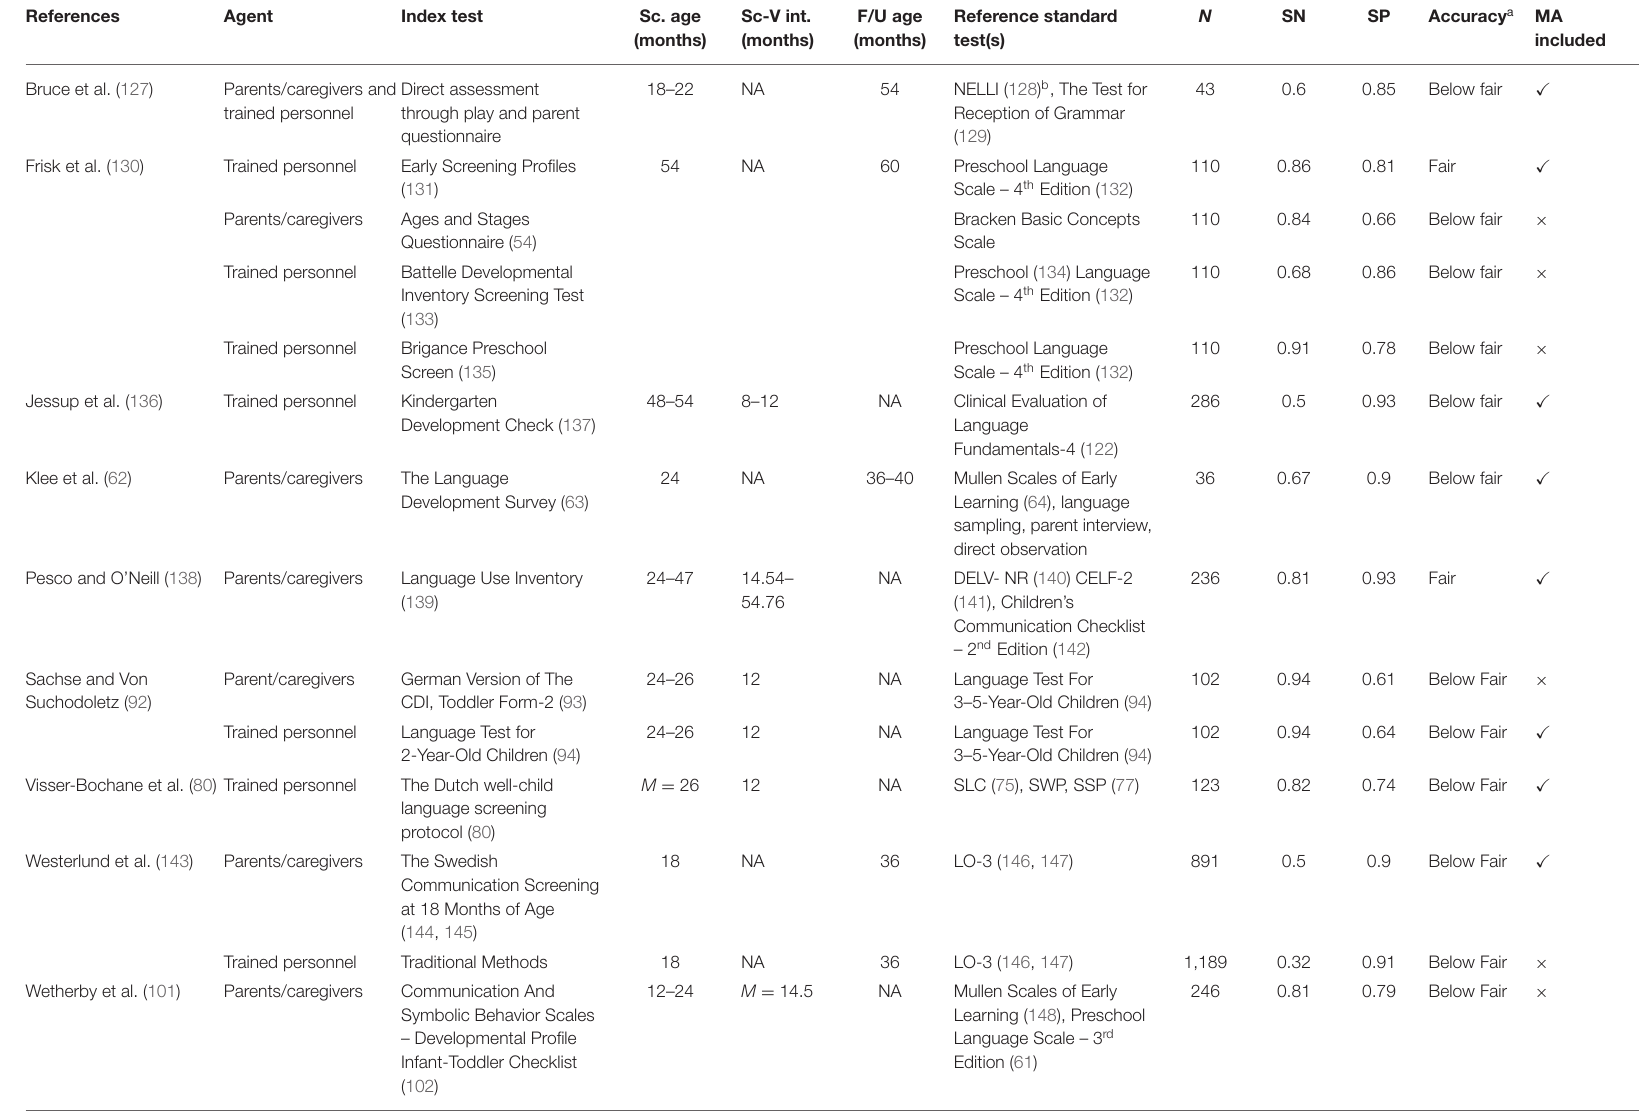
TABLE 6 | Studies assessing predictive validity of screening